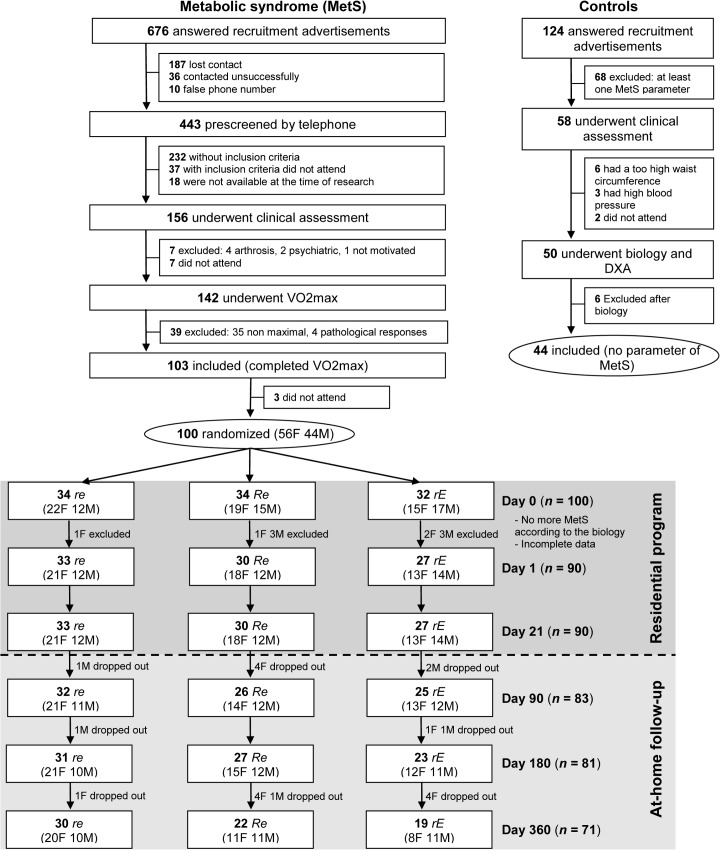
Flow chart of participants.
re: moderate-resistance-moderate-endurance; Re: high-Resistance-moderate-endurance; rE: moderate-resistance-high-Endurance.